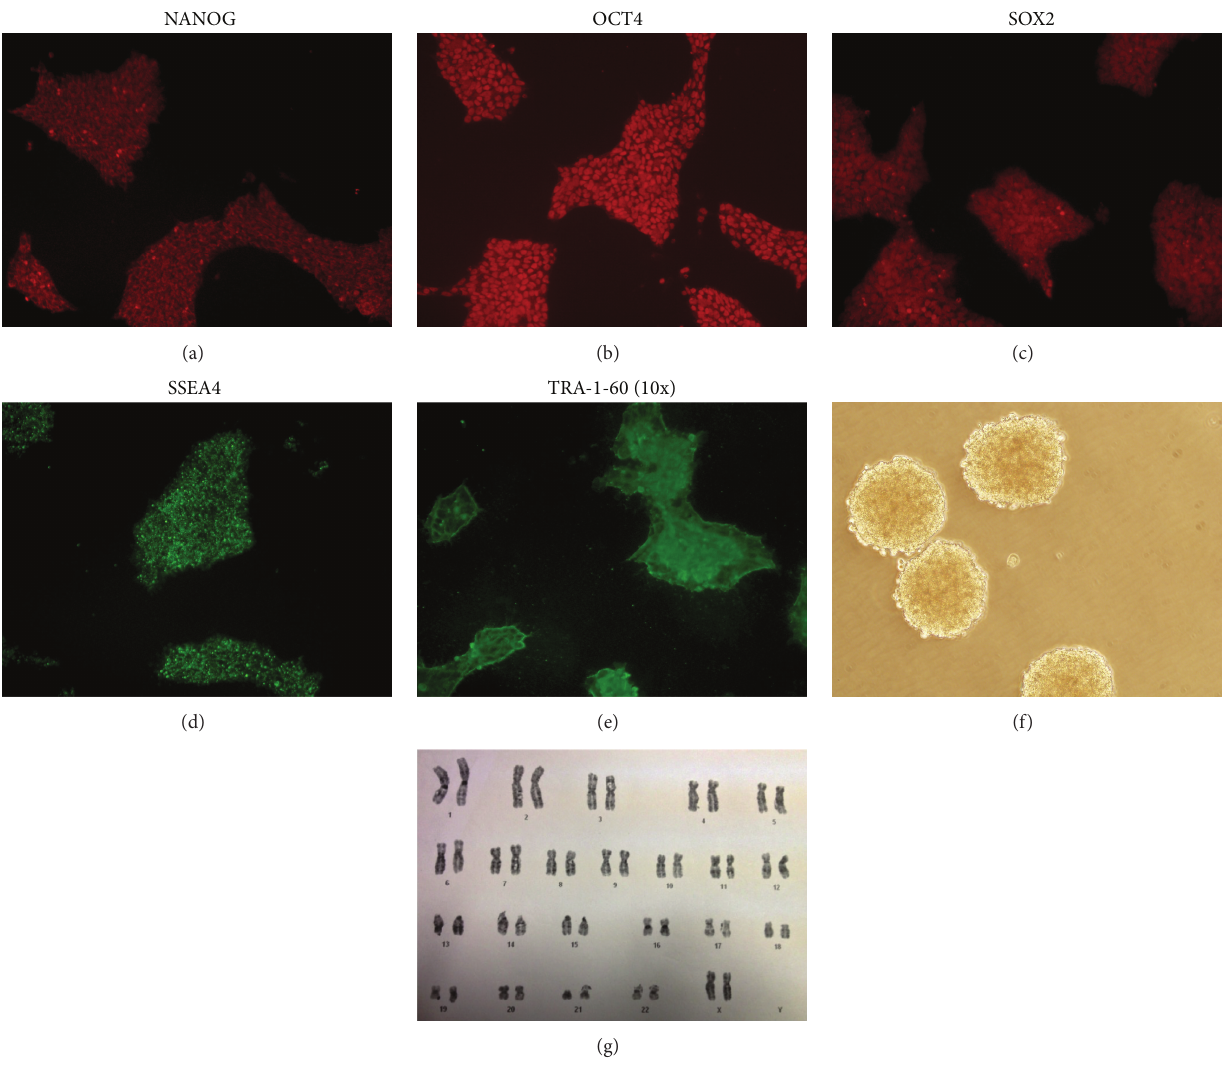
Figure 1: iPSC characterization. (a–e) Immunofluorescence shows the protein expression of the pluripotency markers NANOG, OCT4, SOX2, SSEA4, and TRA-1-60 (10x). (f) Embryoid body formation by the clones shows generation of the three germ layers in vitro . (g) Karyotyping showed no chromosomal